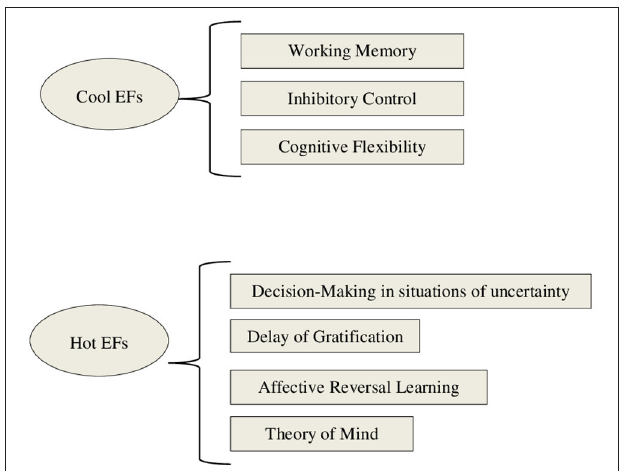
FIGURE 1 | Framework of executive function processes based on Zelazo and Carlson (2012) and Zimmerman et al.